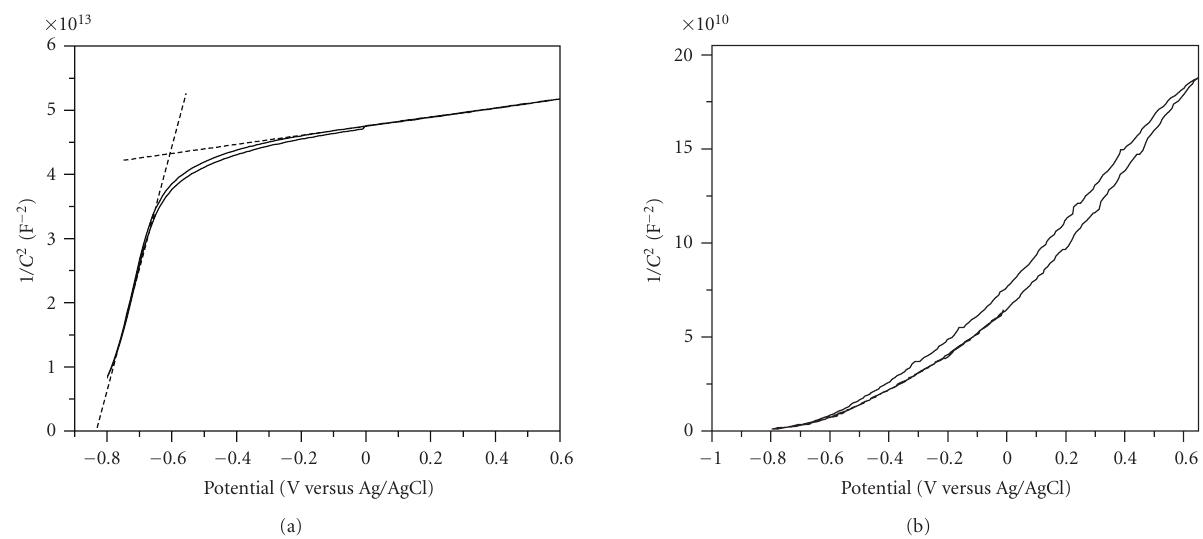
Figure 3: Mott-Schottky measurement of Fe 2 O 3 films (a) undoped, measured at 30kHz and (b) doped with 0.9% Si, measured at 1kHz. The frequency was selected based on the impedance spectra (not shown), in the range where the slope of log |− Z (cid:6)(cid:6) | versus log( ω ) is close to − 1, and the real part of impedance is more or less constant